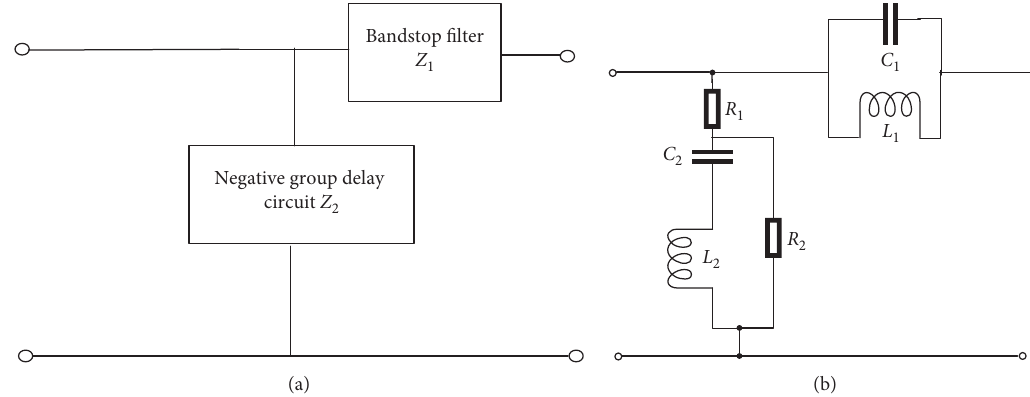
Figure 1: (a) Block diagram of the band-stop filter with negative group delay. (b) The circuit of the band-stop filter with negative group delay.